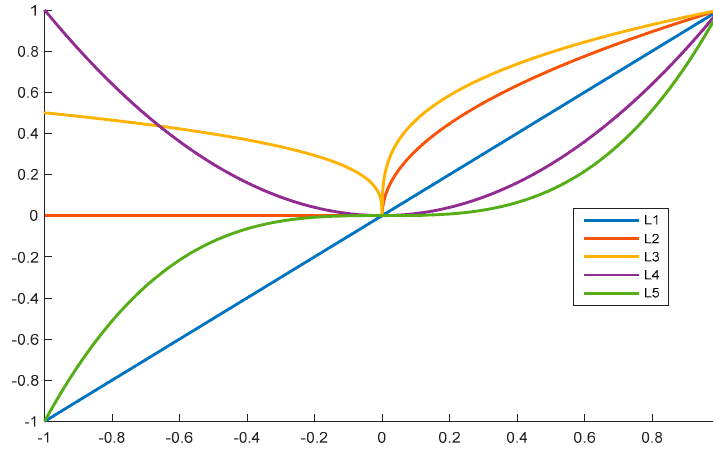
Figure 5. Curves of Equations (4) to (8) in the range [ − 1, 1].